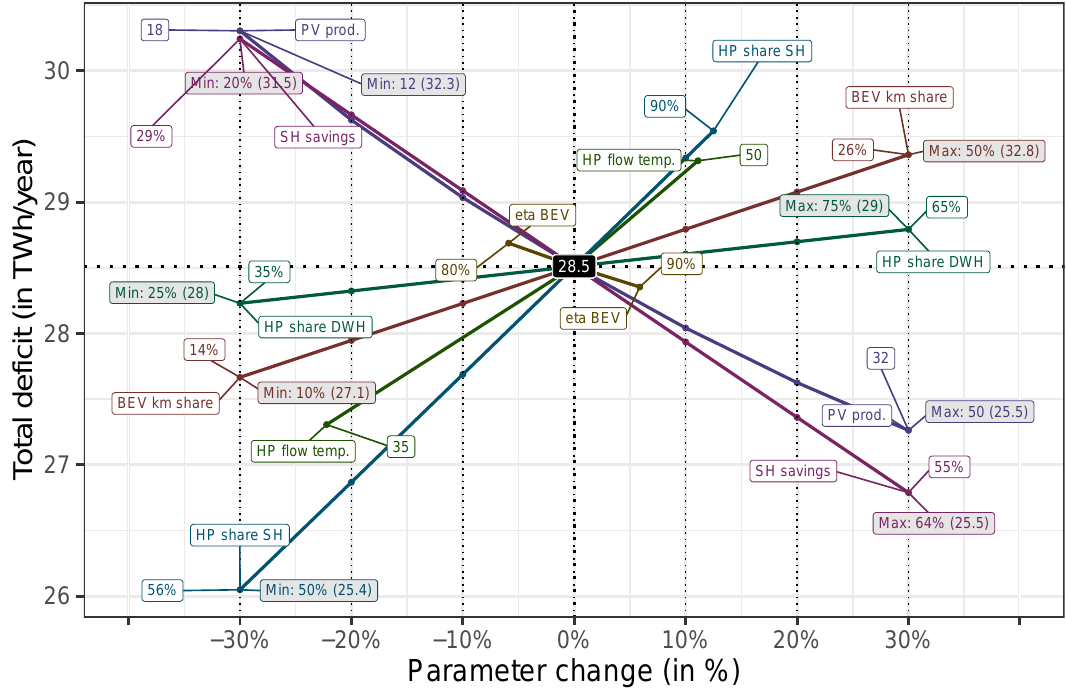
Figure 22. Sensitivity plot of the total annual electricity deficits with respect to plausible percentage changes of the key parameters in Table